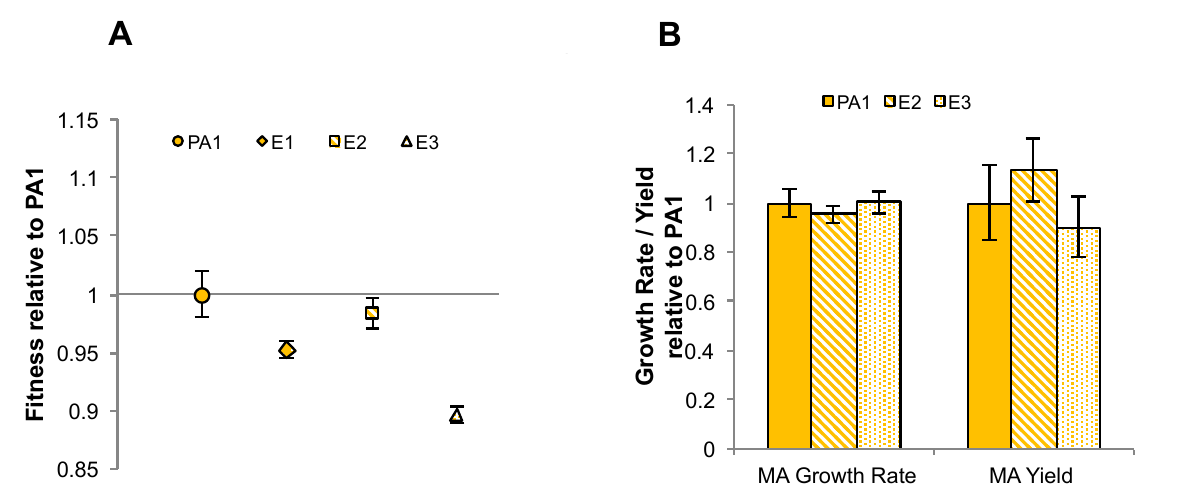
Figure 7. ( A ) MA fitness of Δ cel M. extorquens PA1 (orange) and an evolved isolate from each population (E1: diamond, E2: square and E3: triangle) relative to mCherry labelled strains of Δ cel M. extorquens PA1; ( B ) MA growth rate and yield (maximum OD 600 ) of E2 (orange stripes) and E3 (orange dots) relative to PA1 (solid